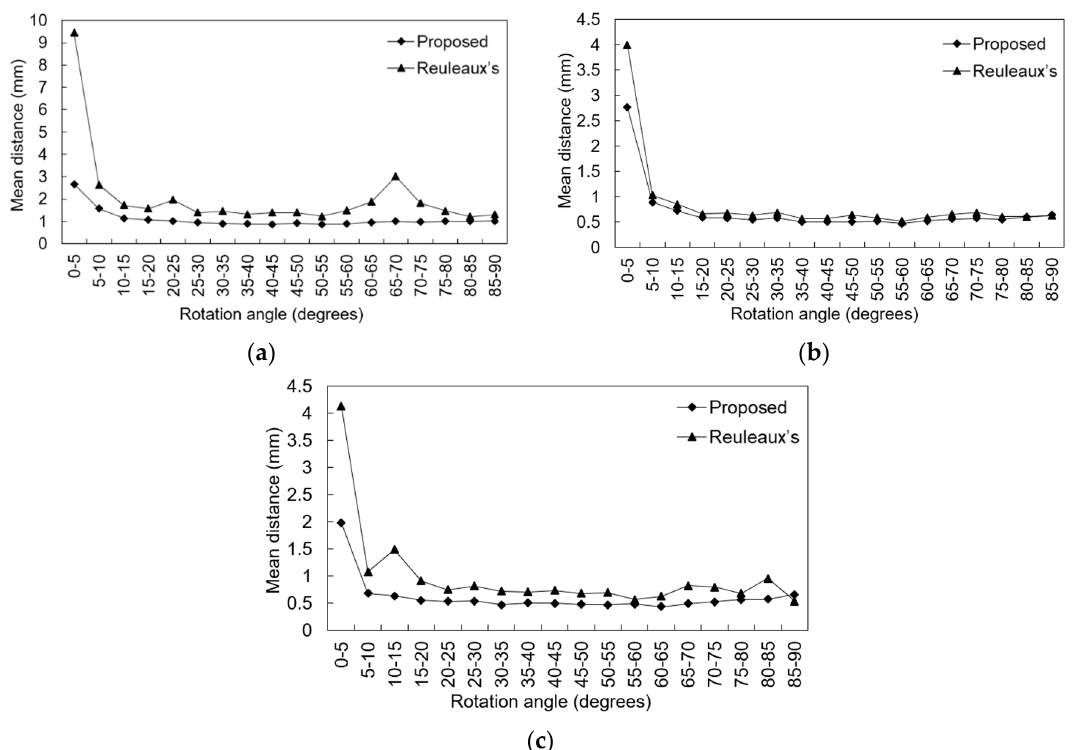
Figure 12. The average of mean distances of an estimated finite joint CoR to other estimated finite joint CoRs at each rotation angle group for ( a ) the metacarpophalangeal joint, ( b ) the proximal interphalangeal joint, and ( c ) the distal interphalangeal